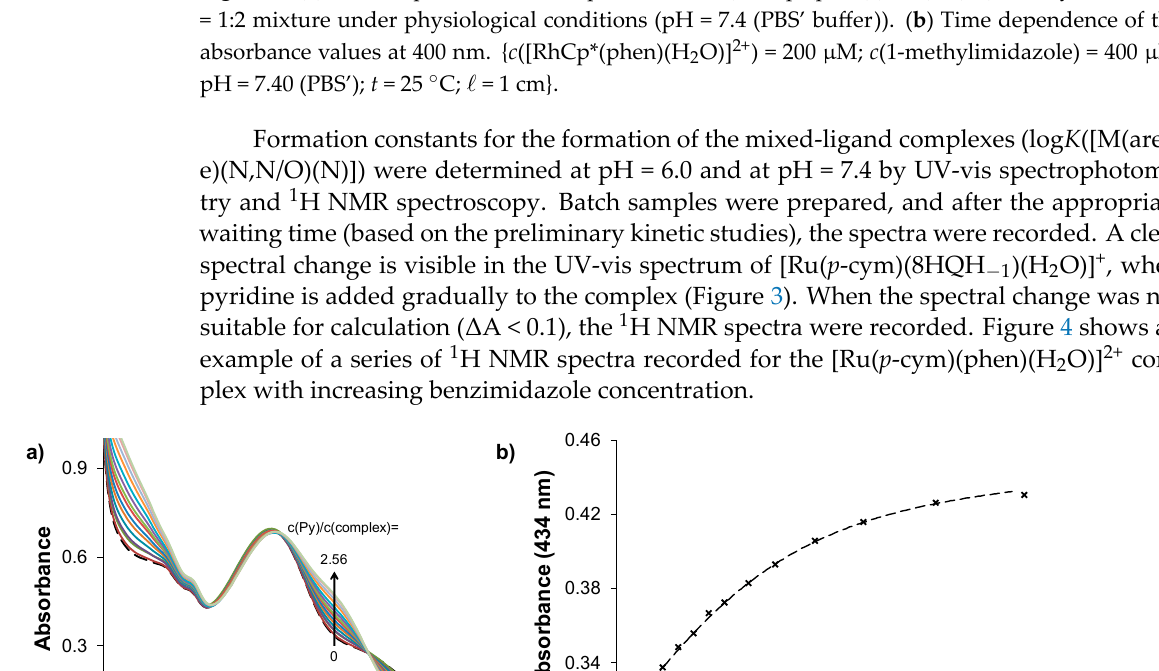
Figure 2. ( a ) Time‑dependent UV‑vis spectra of the c ([RhCp*(phen)(H 2 O)] 2+ ): c (1‑methylimidazole) = 1:2 mixture under physiological conditions (pH = 7.4 (PBS’ buffer)). ( b ) Time dependence of the absorbance values at 400 nm. { c ([RhCp*(phen)(H 2 O)] 2+ ) = 200 µ M; c (1‑methylimidazole) = 400 µ M; pH = 7.40 (PBS’); t = 25 °C; ℓ = 1 cm}.